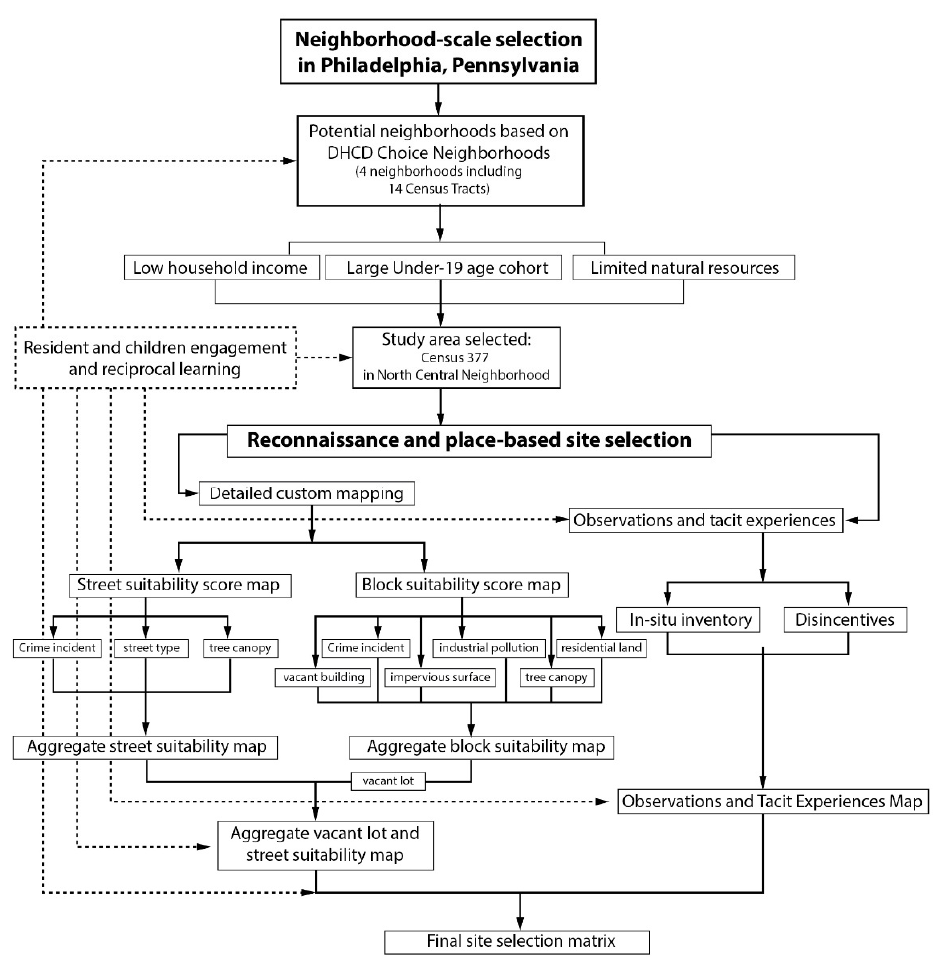
Figure 1. Method flow of study venue selection and mapping.